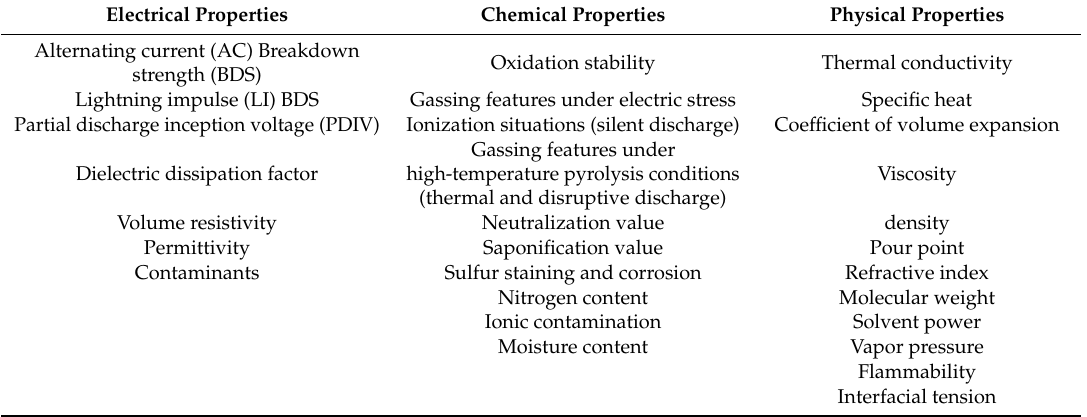
Table 1. Properties of fluid